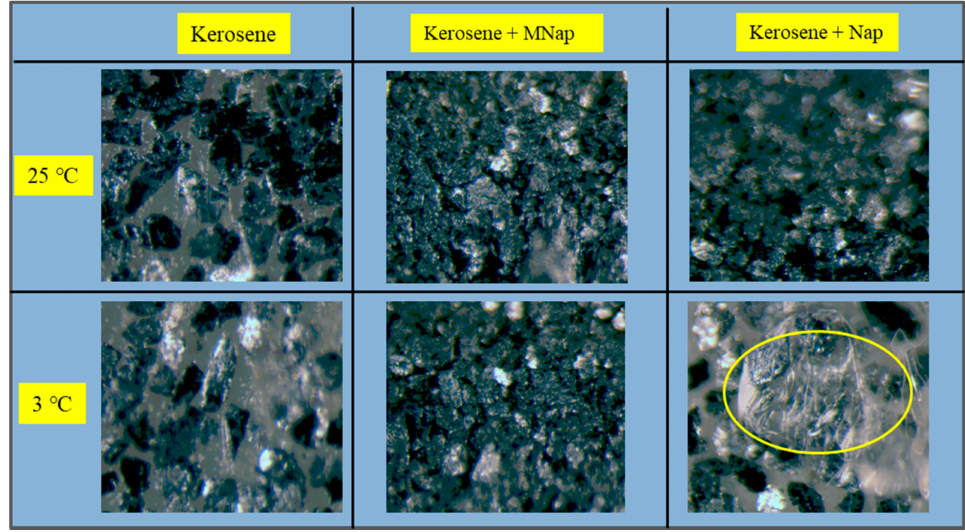
Figure 12. Surface changes of flotation concentrate at different